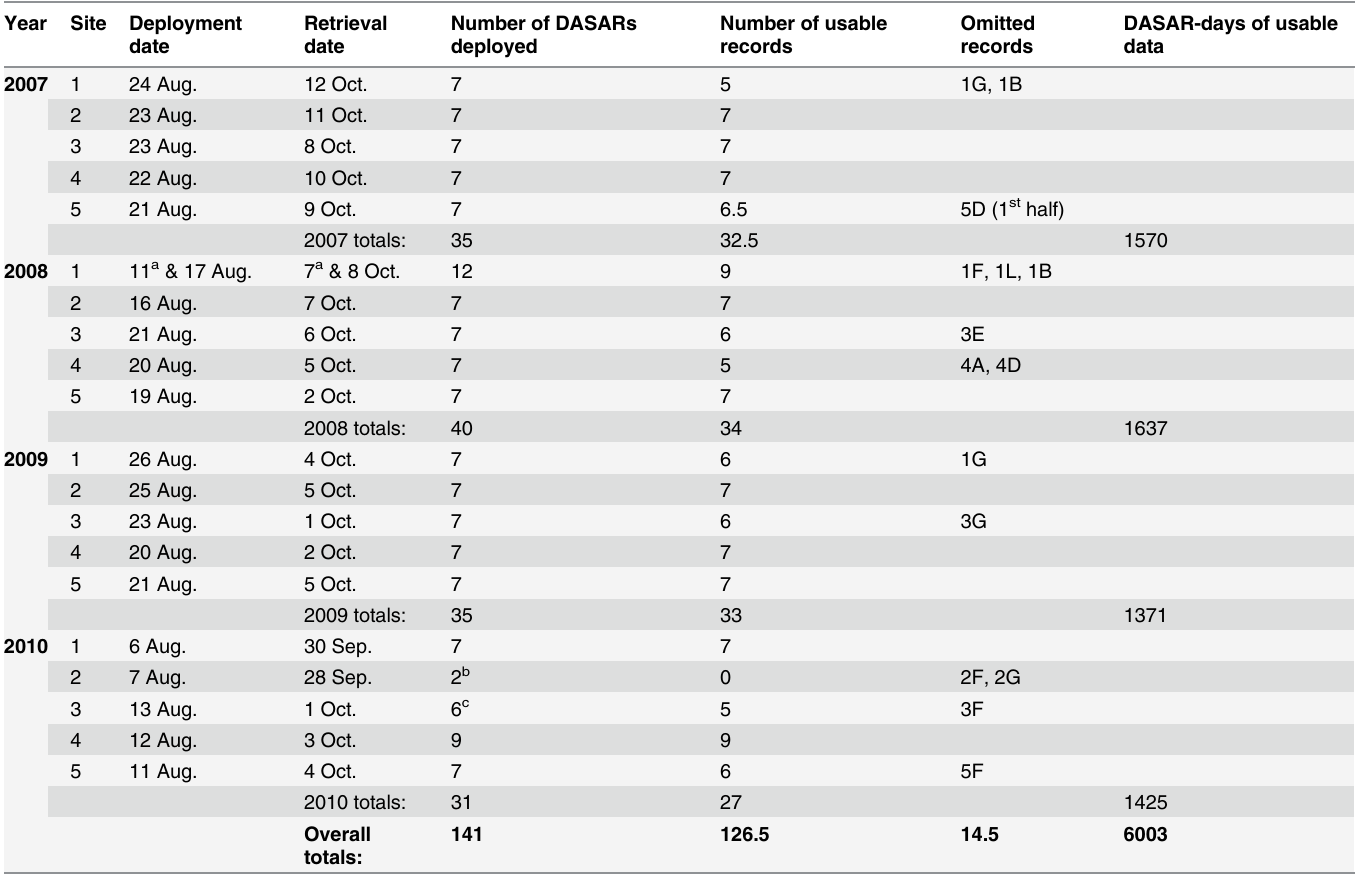
Table 1. Deployment and retrieval dates at all sites, number of records obtained, and days of useable